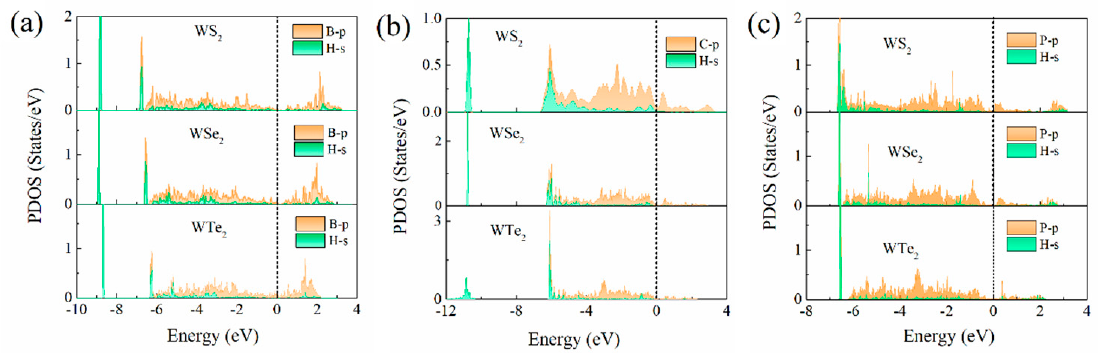
Figure 4. The partial density of states (PDOS) between the H_s orbital and the B/C/P_p orbital for ( a ) B-, ( b ) C-, and ( c ) P-doped T’-WS 2 , WSe 2 , and WTe 2 , respectively. The vertical dotted lines denote the Fermi level.